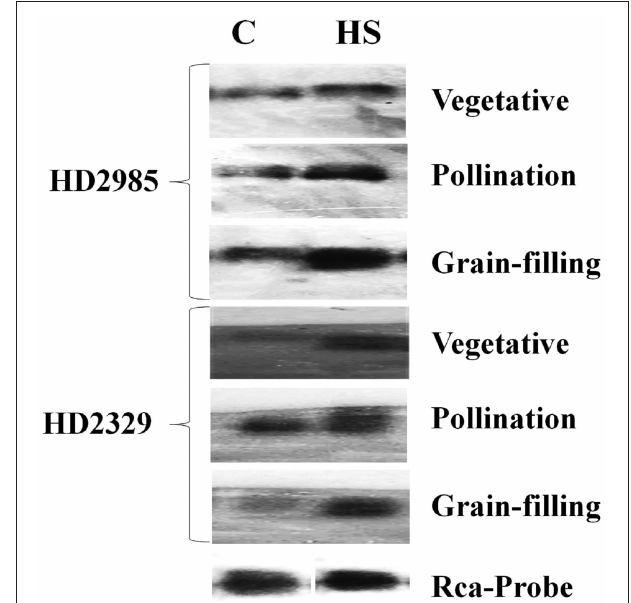
FIGURE 3 | Northern blot analysis of cloned RuBisCo activase ( TaRca1 ) gene in contrasting wheat cvs . HD2985 and HD2329 at different stages of growth and development; [ α - 32 P]-dCTP (300 µ Ci) were used for the probe labeling; 1.2% agarose gel was used for the electrophoretic separation of total